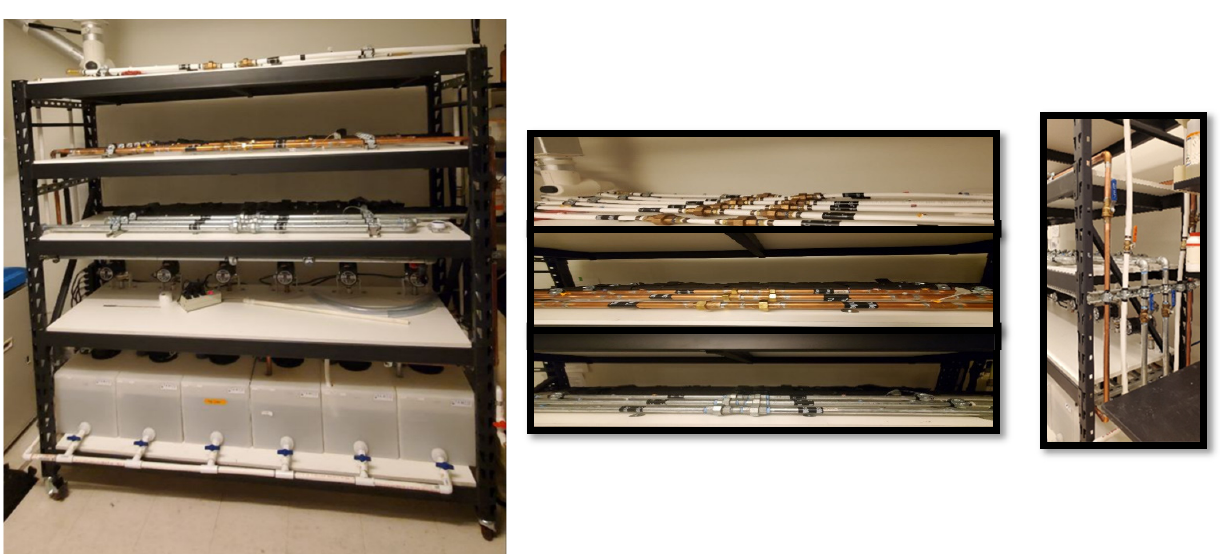
Figure 1. Model drinking water distribution systems—from left to right, front, top and side views. (Front view; tank reservoirs (1st tier, from bottom), pumps (2nd tier), galvanized steel (3rd tier), copper (4th tier), PEX pipes (5th tier)).